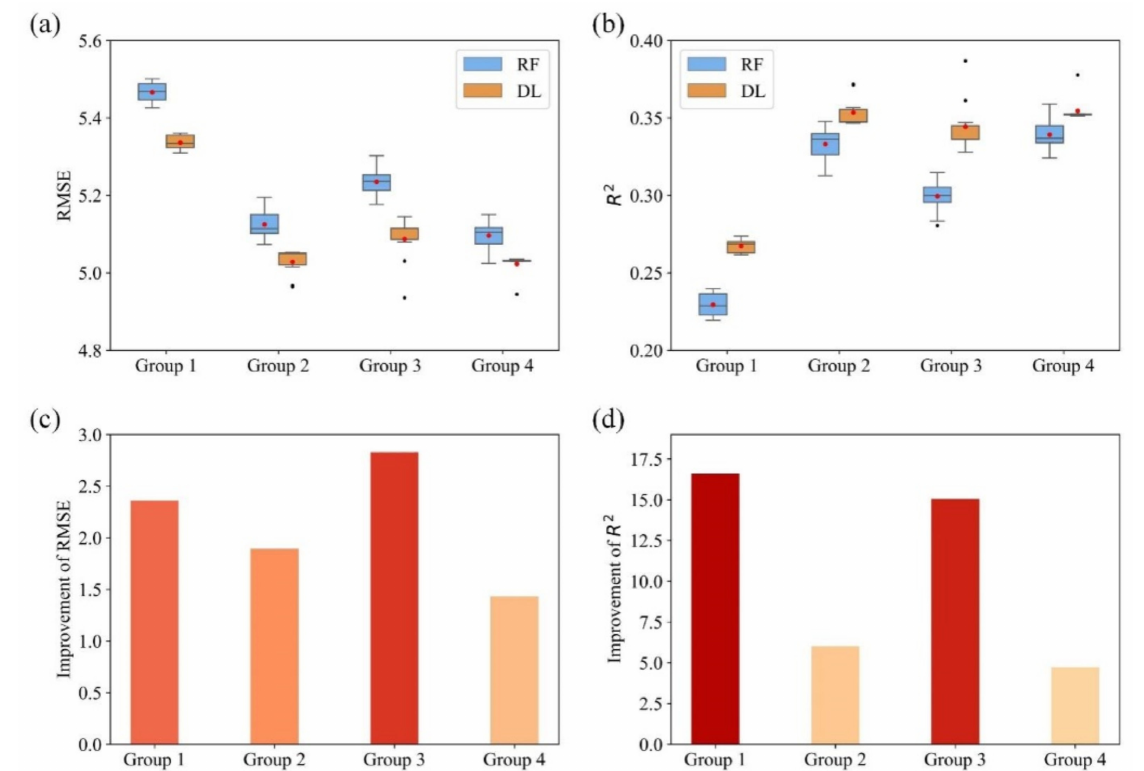
Figure 8. Accuracy and accuracy improvement in terms of RMSE ( a , c ) and R 2 ( b , d ) for predicting SOC using the four groups of covariates with the deep learning (DL) and random forest (RF) models. Note: For the DL models, the CNN model was adopted for the first group, and the CNN-LSTM model was adopted for other three